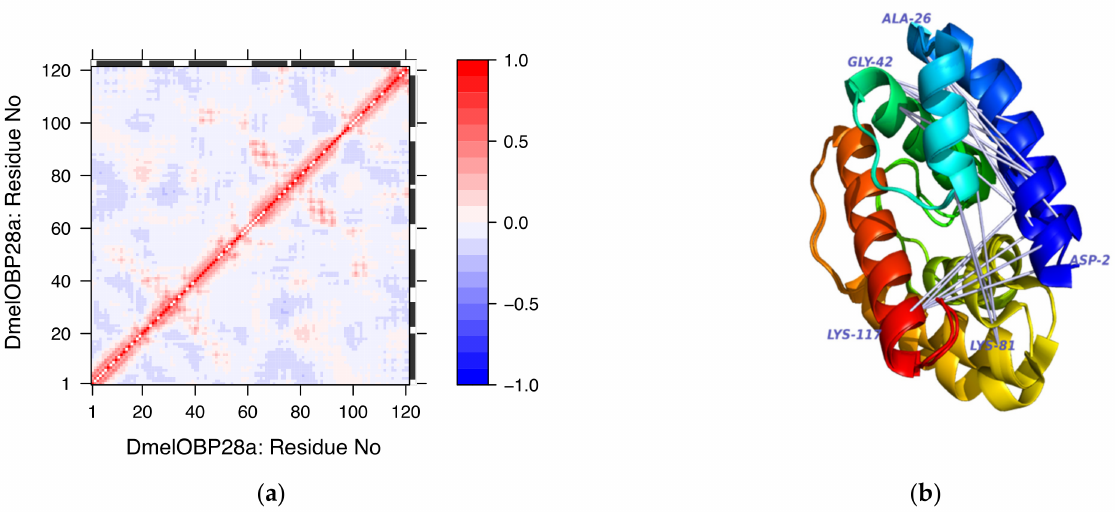
Figure 11. Pairwise residue cross-correlation matrix of DmelOBP28a (Panel a ). Superposed structures of the DmelOBP28a in ligand-free and ligand-bound conformations. Visualisation of anticorrelated motions shown on the superimposed ligand-free and liganded conformers. Correlated motions are not shown (Panel b